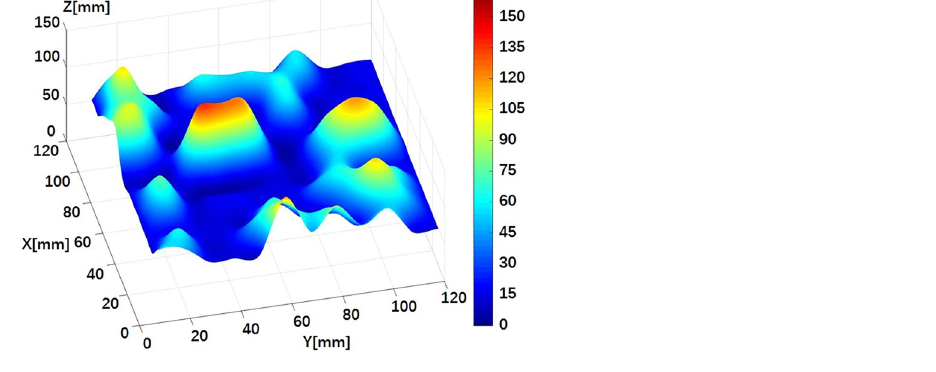
Figure 4. Three-dimensional space image of a sample of cultivated